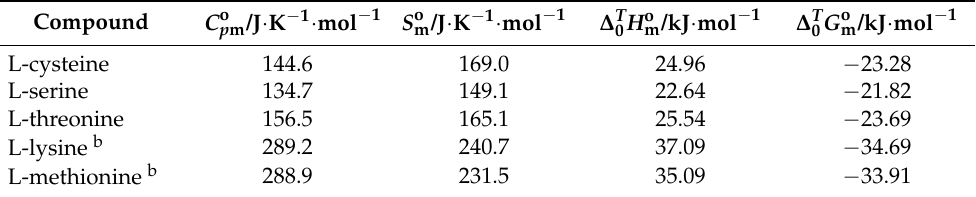
sents the heat capacity or the thermodynamic property. Values are reported with one digit more than is justified by the experimental uncertainty to avoid round-off errors in calculations based on